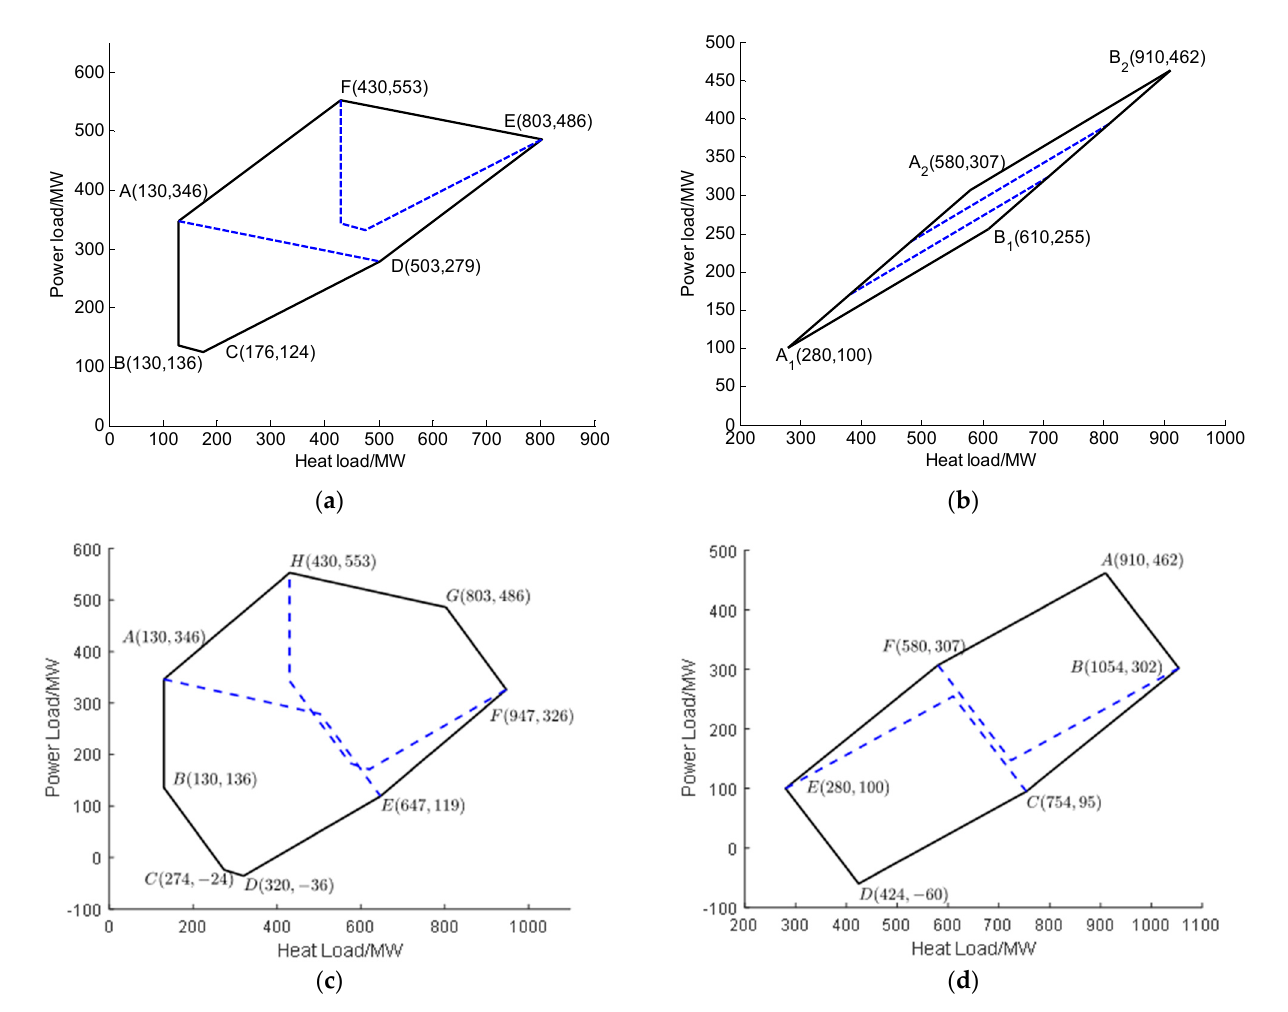
Figure 3. The power and heat working range of the CHP under different operation modes. ( a ) HBP + EH. ( b ) HBP + LPCC. ( c ) HBP + EH + EB. ( d ) HBP + LPCC + EB.